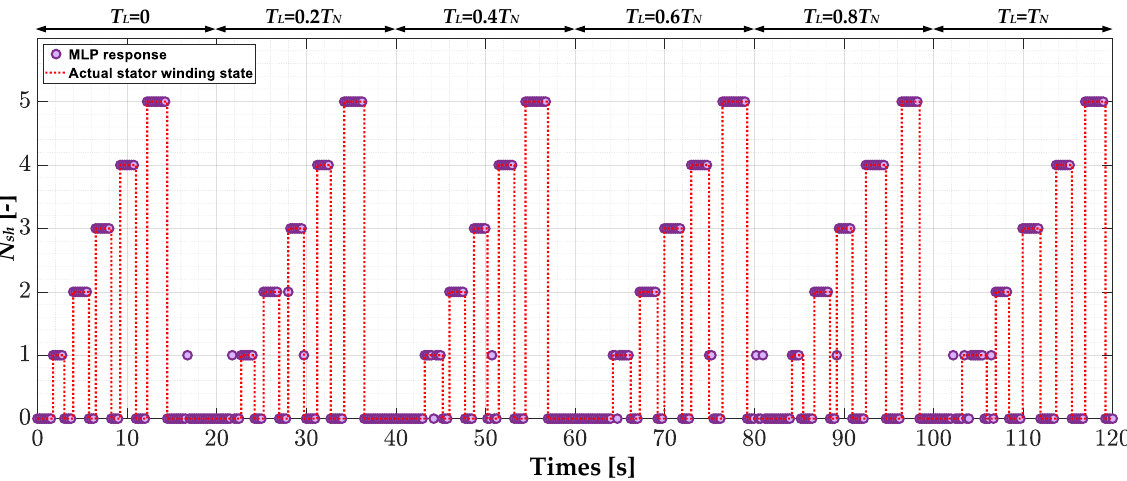
Figure 20. The actual states of the stator windings and MLP model responses of the fault classifier models for on-line operation of the PMSM